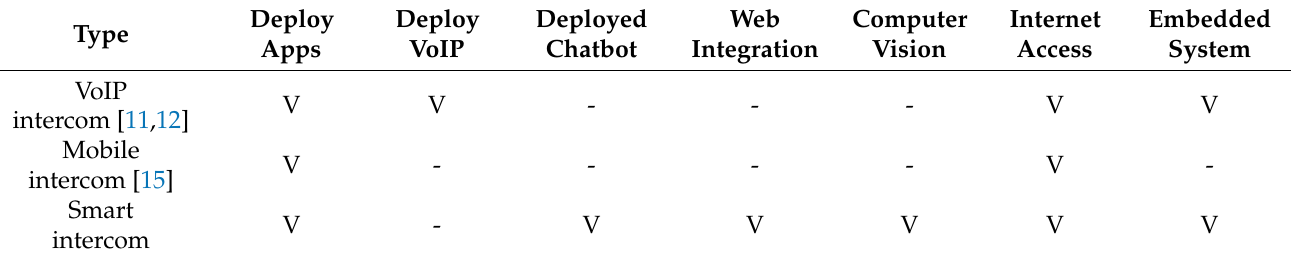
Table 2. Intercom use technology